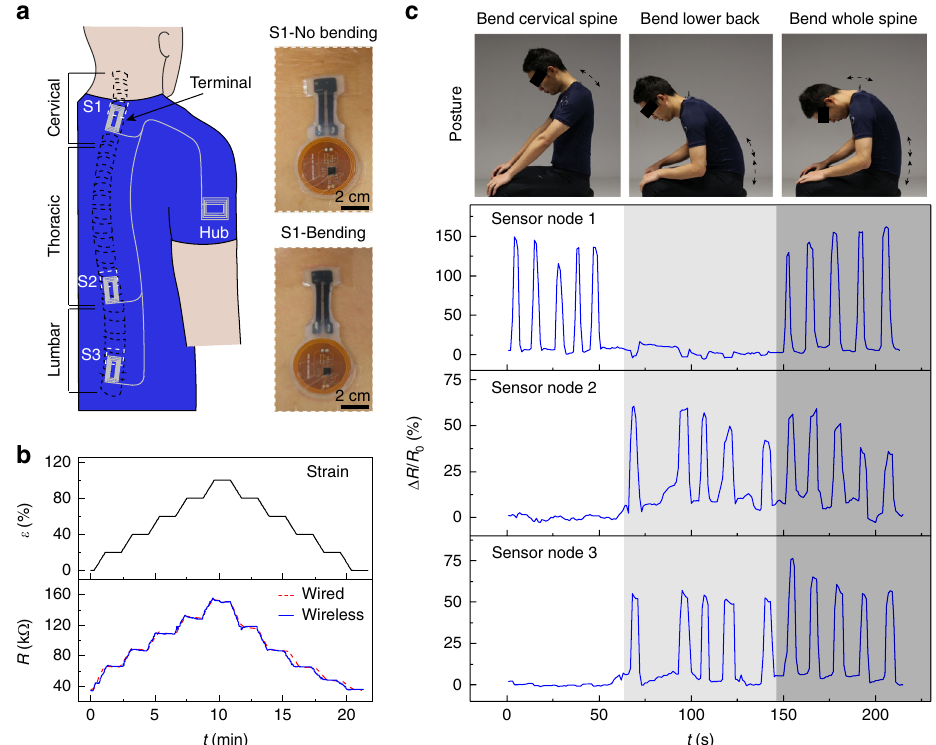
Fig. 3 Multi-node spinal posture monitoring with battery-free sensors. a Schematic of a wireless sensor system for real-time posture monitoring. Battery- free strain sensors mounted on cervical (S1), thoracic (S2), and lumbar (S3) sections are simultaneously interconnected to an NFC hub device via the near- fi eld-enabled clothing. Photographs show example of S1 without/with bending cervical spine. b Pro fi le of applied strain ε and measured sensor resistance R acquired through wired connection and wireless NFC. ε is cycled from 0 to 100% with a step size of 20%. c Sensor data acquired during human subject motion. The subject sequentially bends the cervical spine, lower back, and whole spine, repeating each motion for fi ve